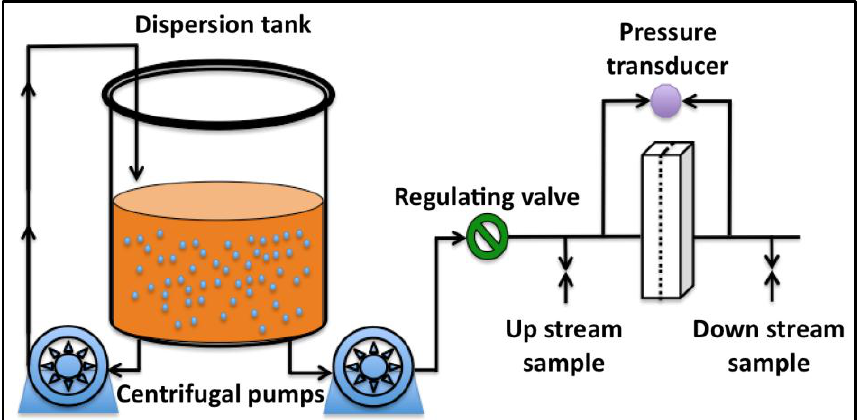
Figure 2. Dispersion setup: Two centrifugal pumps were used, the first pump was used for circulating water-diesel mixture in the dispersion tank and the other pump was used to pump the dispersion to the filter medium.